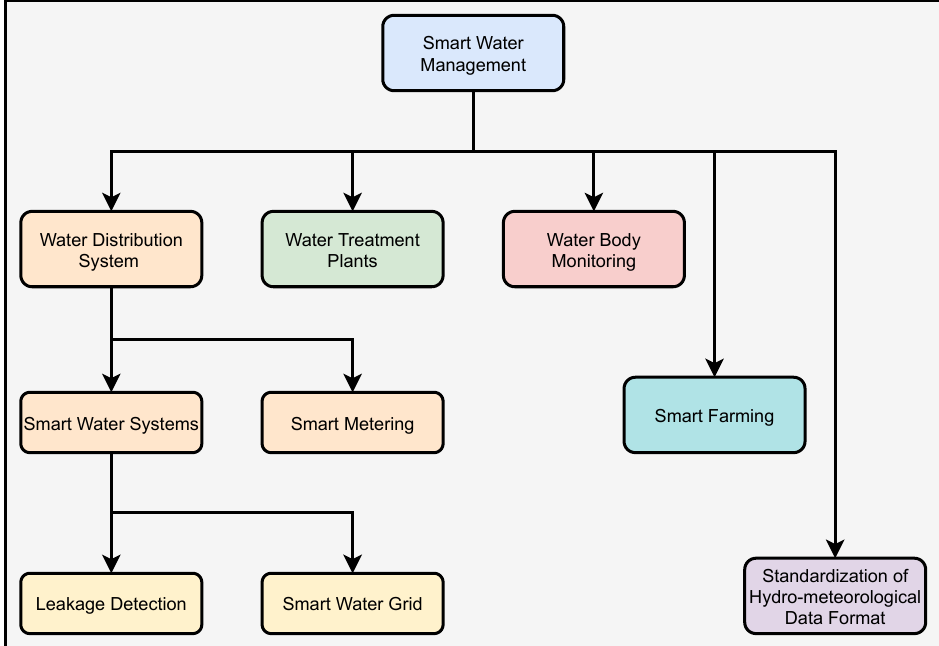
Figure 1. The organization of the discussed topics in this survey.